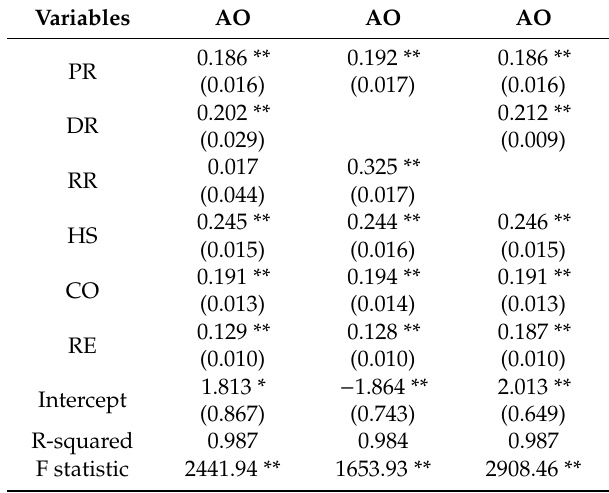
Table 4. Numerical scores of AO regressed on six category numerical score